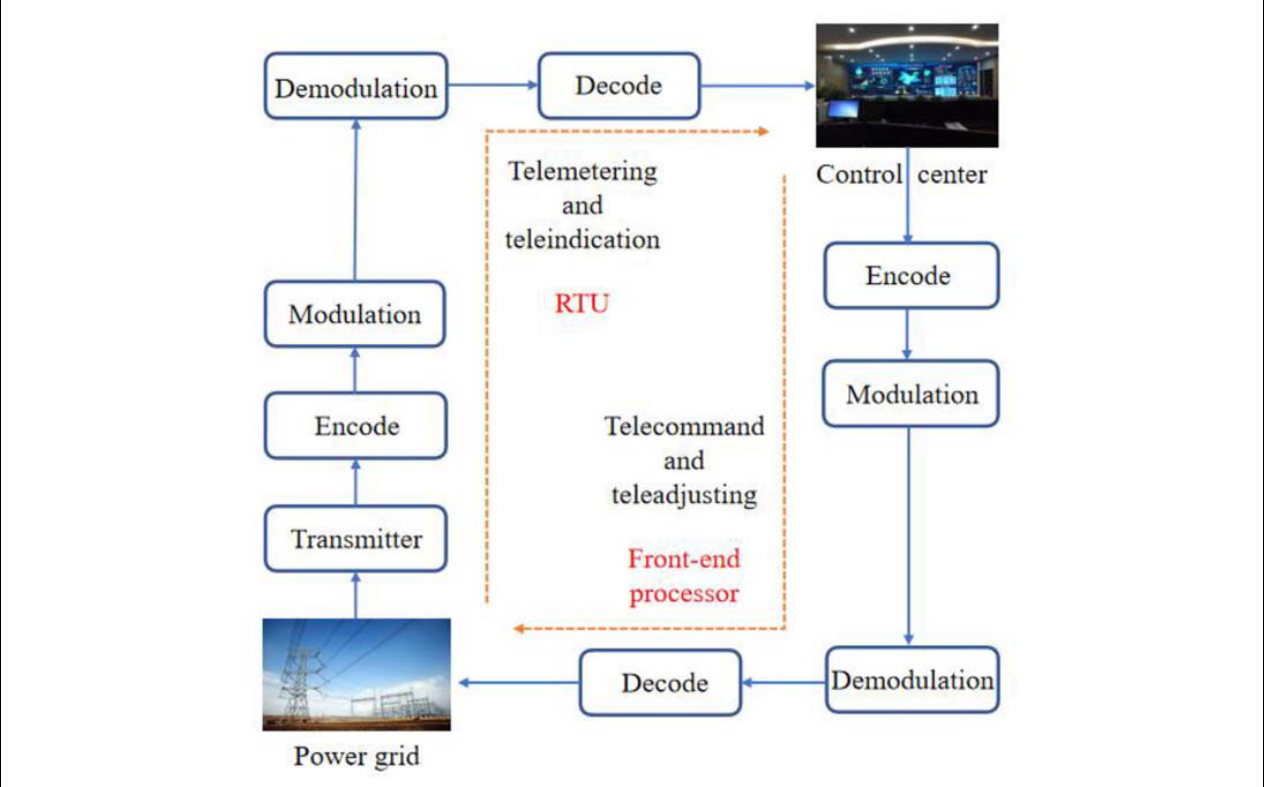
FIGURE 2 | Data communication